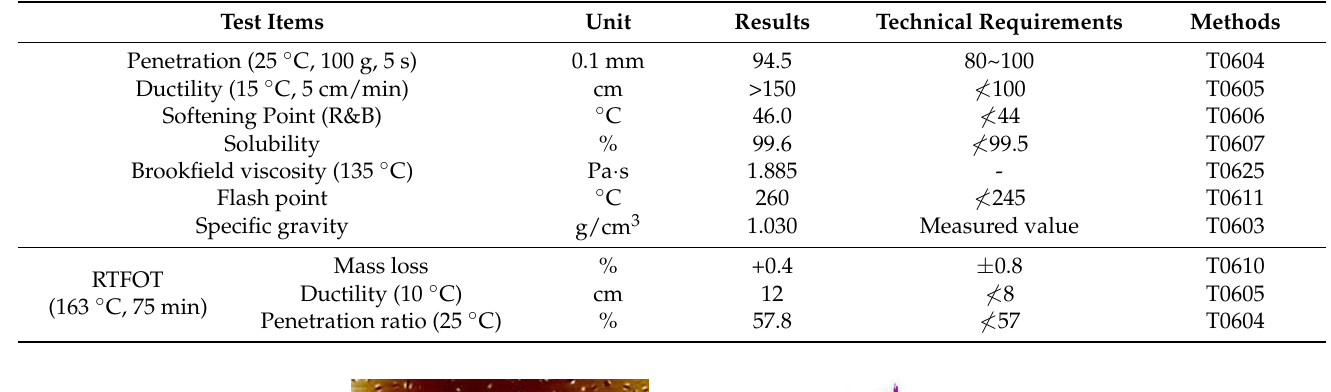
Table 1. Technical indicators of SK-90# matrix asphalt.